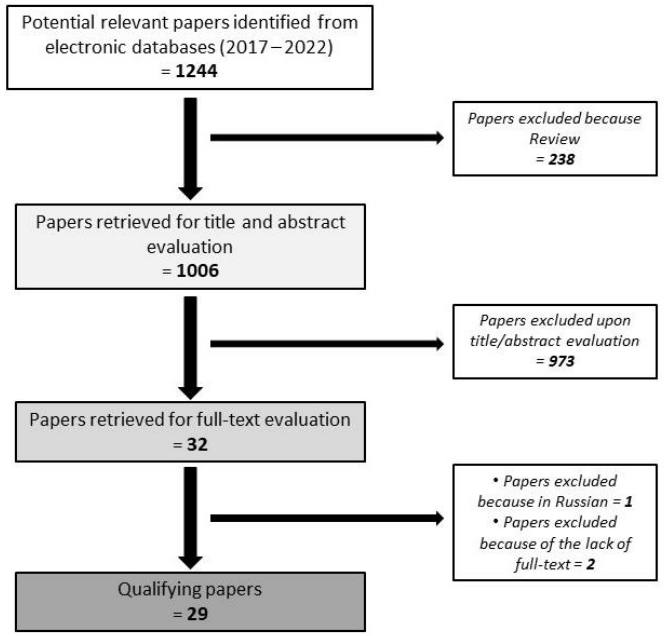
Figure 1. Literature search strategy and studies selection.